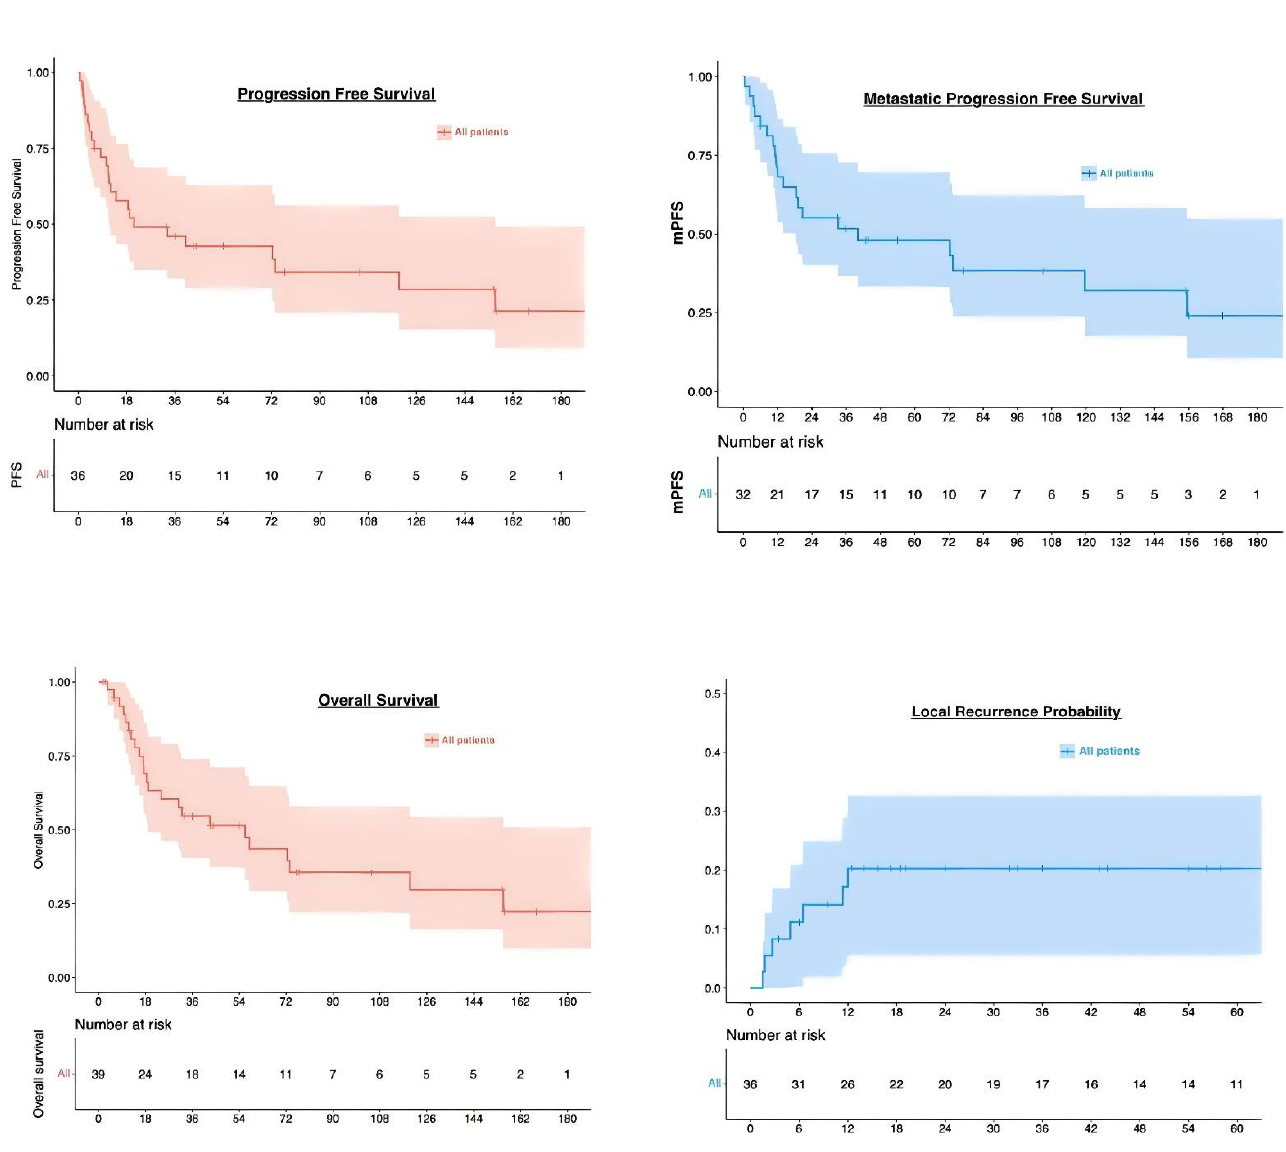
Figure 2. Survival and local recurrence probability curves.